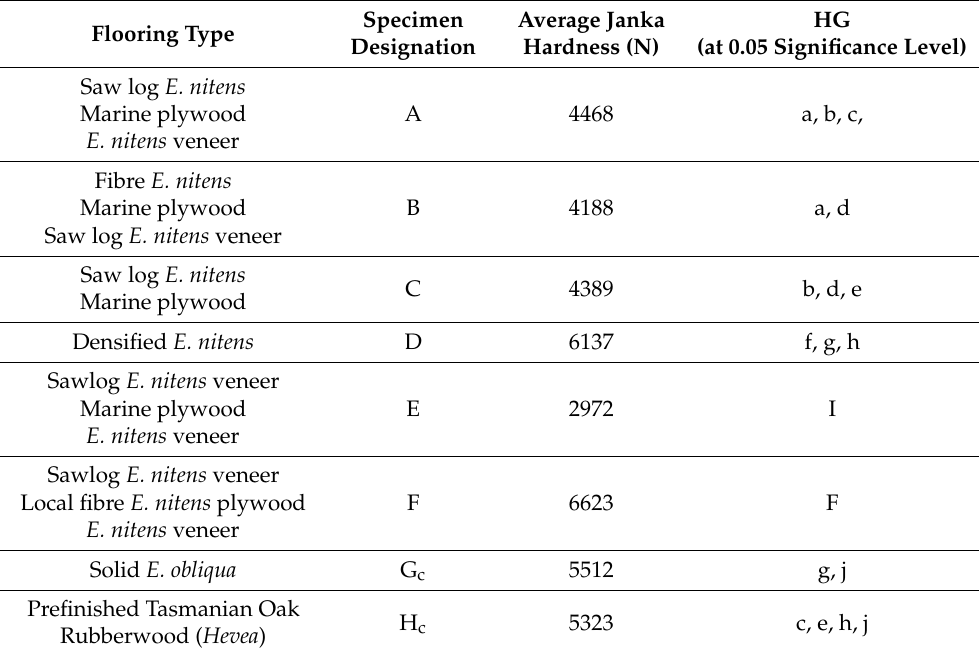
Table 3. Janka hardness of engineered flooring prototypes and controls with homogenous groups